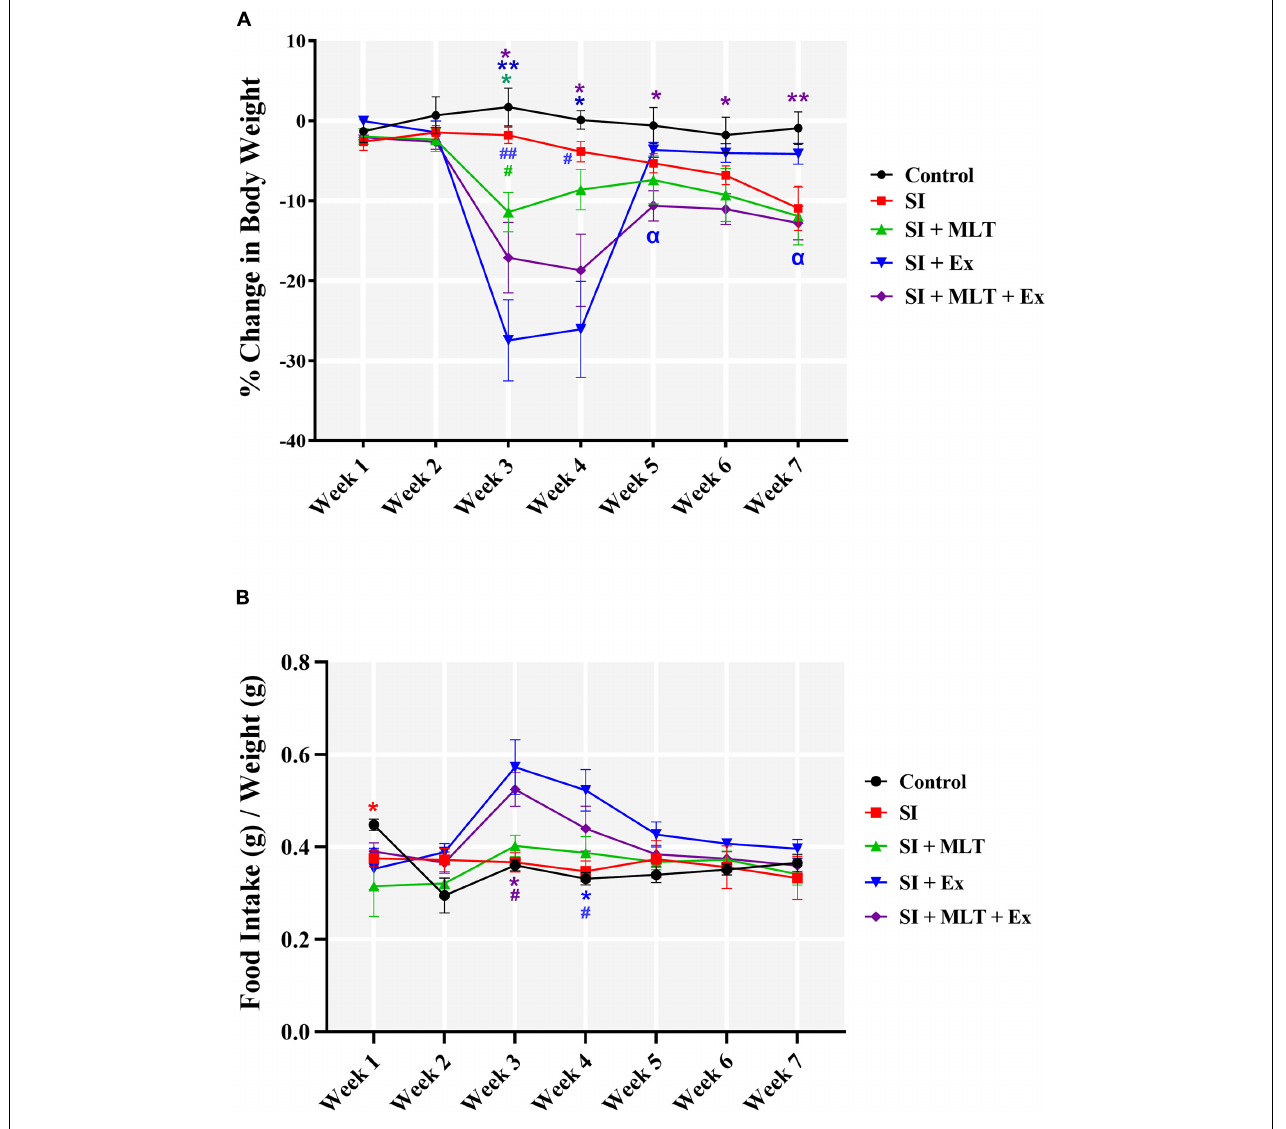
FIGURE 2 | (A) The effect of MLT and Ex on the percentage change in body weight among groups of aged rats. (B) The effect of MLT and Ex on food consumption among groups of aged rats. Data are presented as mean ± standard error of the mean (SEM). Two-way repeated measures ANOVA was used, followed by Tukey’s multiple comparisons test. * indicates a significant difference between the treated groups and the control group at p > 0.05; # indicates a significant difference between the treated groups and the SI group at p > 0.05; α indicates a significant difference between the treated groups and the combination group at p > 0.05; ** P < 0.01; ## P < 0.01. The color of the symbol denotes comparisons between groups with the matching color and